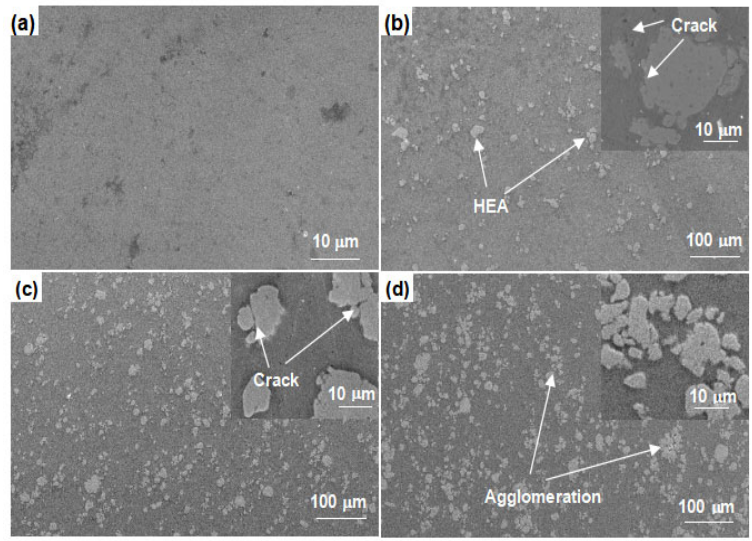
Figure 5. Microstructure and morphology of (AlFeNiCrCoTi0.5)p/6061Al composites with different volume fractions: ( a ) 6061Al; ( b ) 5 vol.%; ( c ) 10 vol.%; ( d ) 15 vol.%.